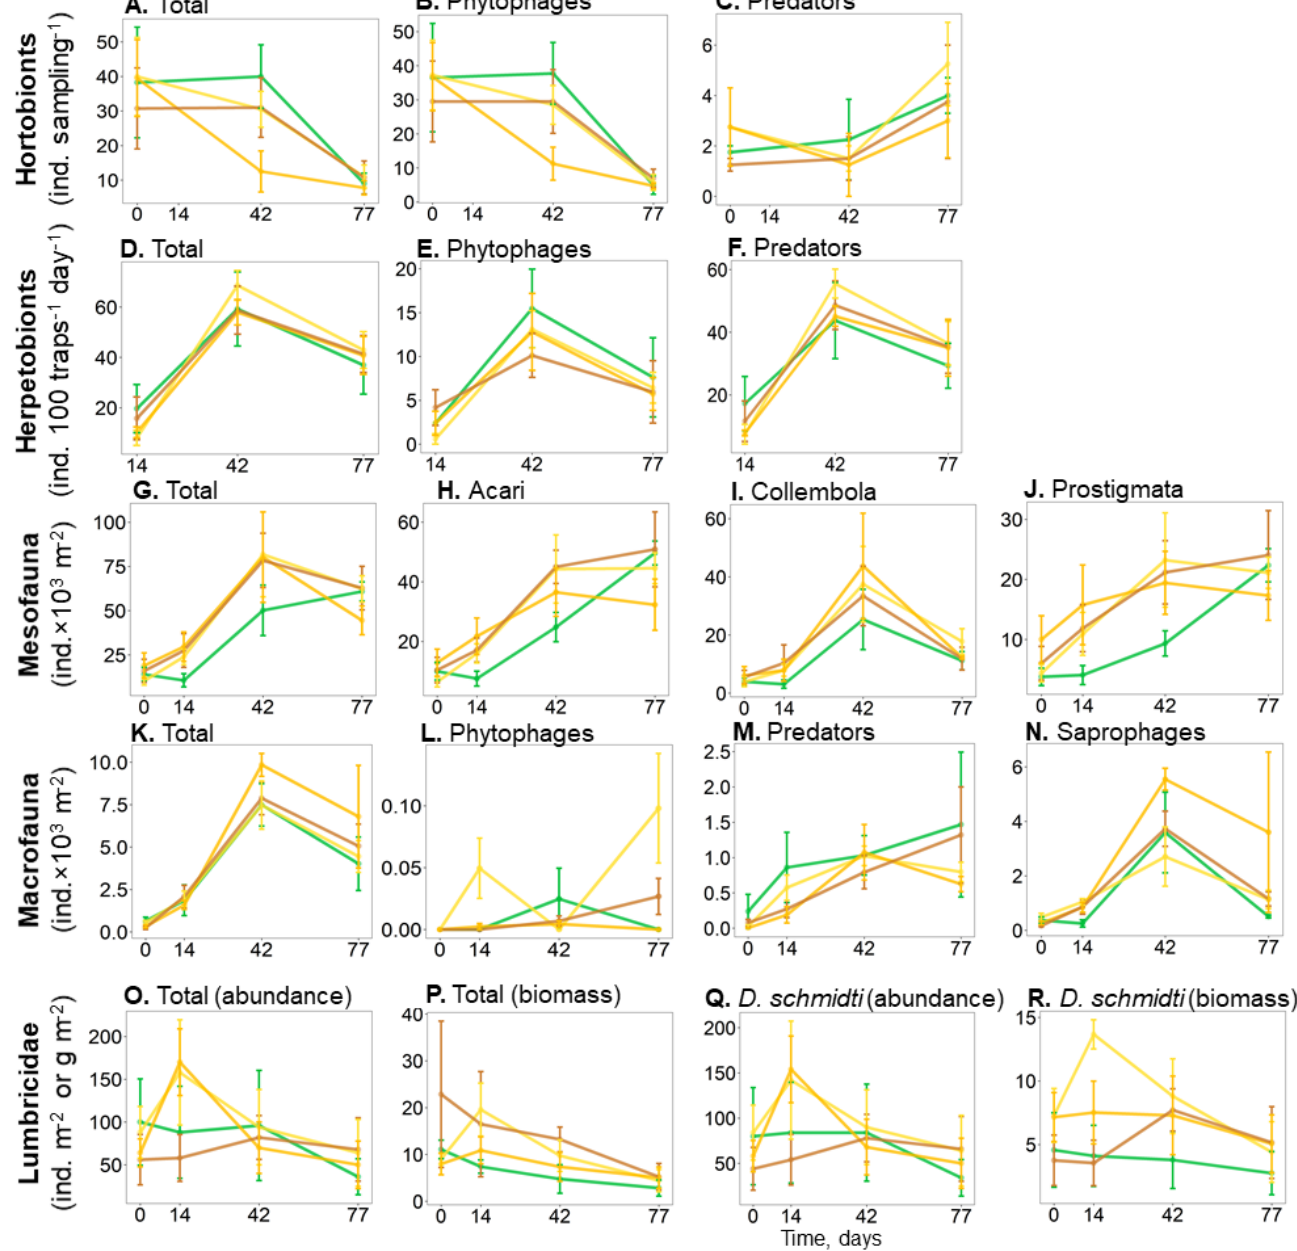
Figure 3. Dynamics of the abundance of hortobionts ( A – C ), herpetobionts ( D – F ), soil mesofauna ( G – J ), soil macrofauna ( K – N ) and earthworms ( O – R ), in control (green lines), N-poor mulch (yellow lines), N-medium mulch (orange lines), and N-rich mulch (brown lines) treatments. Mean ± 1 S.E., n = 5.